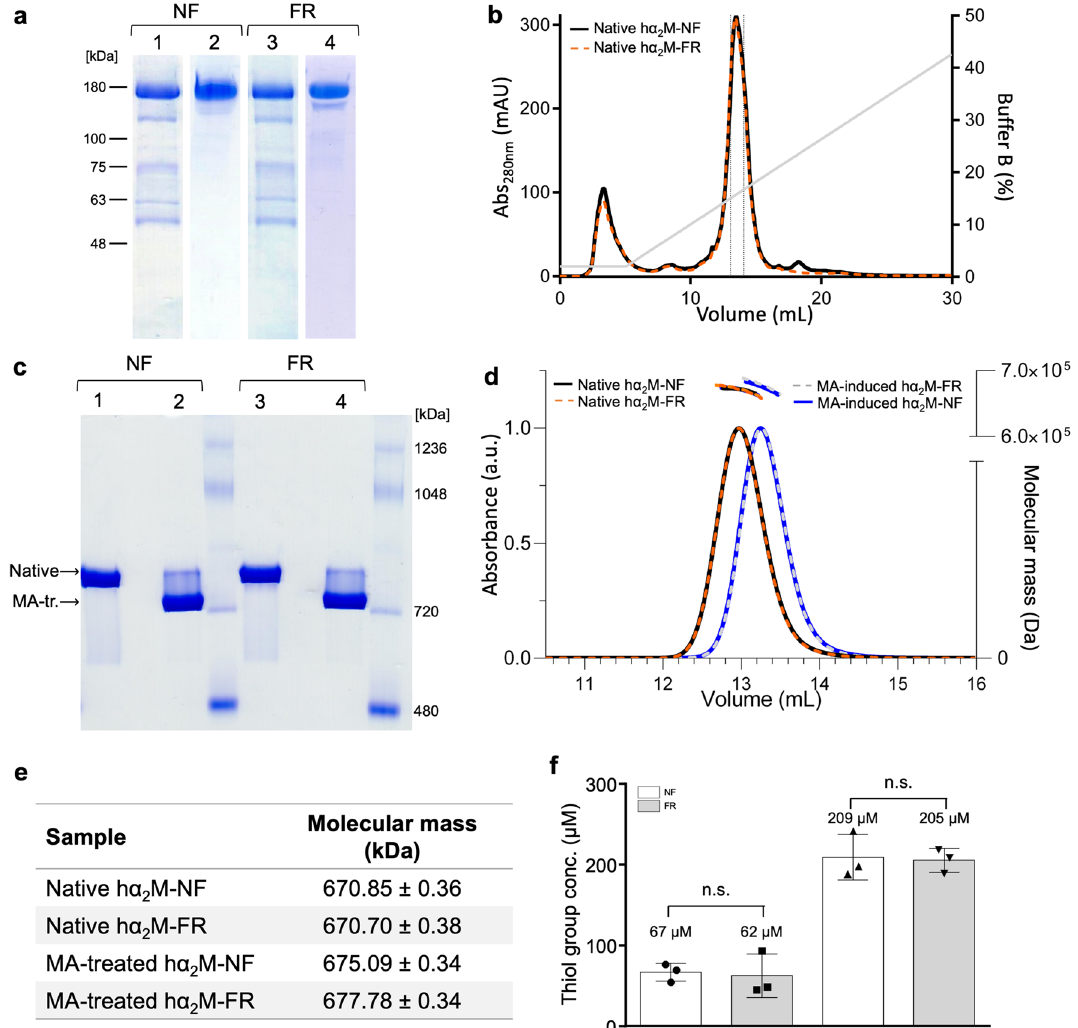
Figure 1. Purification and biophysical analysis of hα 2 M from non-frozen fresh plasma (NF) or frozen fresh plasma (FR). ( a ) SDS-PAGE analysis of elutes from zinc affinity chromatography (lanes 1 and 3) and IEC (lanes 2 and 4). ( b ) Comparison of the IEC profiles of native hα 2 M purified from NF (solid black line) and FR (dashed orange line). ( c ) Native PAGE analysis of native (lanes 1 and 3) and MA-treated induced (lanes 2 and 4) hα 2 M from NF (lanes 1 and 2) and FR plasma (lanes 3 and 4). ( d ) SEC–MALLS analysis of native (black and orange lines) and MA-treated induced (grey and blue lines) protein purified from FR (dashed lines) and NF (solid lines) plasma. ( e ) The molecular masses determined by SEC–MALLS were 671 kDa for the native tetrameric species and 675–678 kDa for the MA-treated species, which match the theoretical value (643.2 kDa) plus glycosylation. ( f ) Concentration of free thiol groups in hα 2 M from non-frozen (NF, white bars) or thawed frozen fresh (FR, grey bars) samples according to Ellmann’s reaction 51 . The protomeric hα 2 M concentration used was 157 μΜ. Data are presented as means ± SD (n = 3). Statistical significance was determined using a two-sided Student’s t-test (n.s., p > 0.1). Panels a-e are representative of more than three independent experimental peptidase trypsin from bovine pancreas and the metallopeptidase thermolysin from Bacillus thermoproteolyticus by testing their activity against a fluorogenic casein derivative (Fig. 2a,b). Both endopeptidases showed equivalent residual activities after preincubation with native hα 2 M from the two preparations at inhibitor tetramer:peptidase molar ratios of 2:1, 1:1 and 1:2. This reflected the ability of cleaved substrate fragments, still labelled with the fluorophore, to access the trapped peptidase, leading to the emission of fluorescent signal as previously reported 54 . At the highest molar ratio (1:4), the inhibitor was saturated and the excess peptidase therefore led to a sudden increase of proteolytic activity (Fig. 2a,b). Again, the FR and NF preparations were indistinguishable, as in the preceding experiments. Finally, we analysed the ability of hα 2 M to inhibit trypsin and thermolysin cleavage of α-casein (32 kDa) and fibrinogen (340 kDa, divided into the three chains Aα, Bβ and γ), which are good substrates for both peptidases, by SDS-PAGE (Fig. 2c–f). We found that hα 2 M inhibited both peptidases at molar ratios between 1:1 and 1:2, and